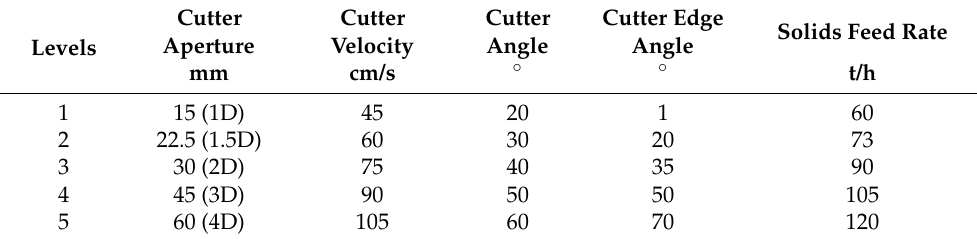
Table 2. Determination of levels for each simulated parameter. Cutter Cutter Cutter Cutter Edge Solids Feed Rate Aperture Velocity Angle Angle Levels mm cm/s ◦ ◦ t/h 1 15 (1D) 45 20 1 60 2 22.5 (1.5D) 60 30 20 73 3 30 (2D) 75 40 35 90 4 45 (3D) 90 50 50 105 5 60 (4D) 105 60 70 120 An equation was used to quantify the ratio of extraction for each particle group. It was defined as an initial mass group, the mass of particles in a specified diameter before sampling. In addition, the final mass group was defined as a final mass of particles in a specific diameter after sampling. The equation compares the percent of particle mass group collected in the sample and the original percent mass group of the lot. The equation is represented